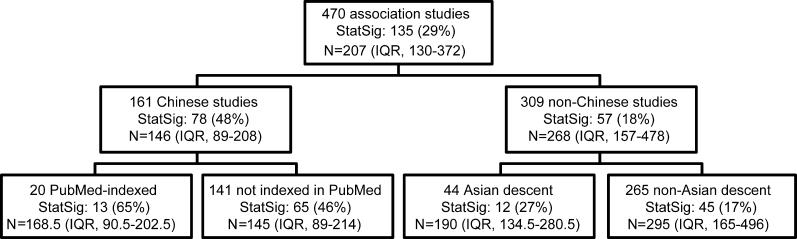
Categorization of the Examined Genetic Association StudiesIQR, interquartile range; N, sample size (as median and interquartile range); StatSig, statistically significant at the 0.05 level.